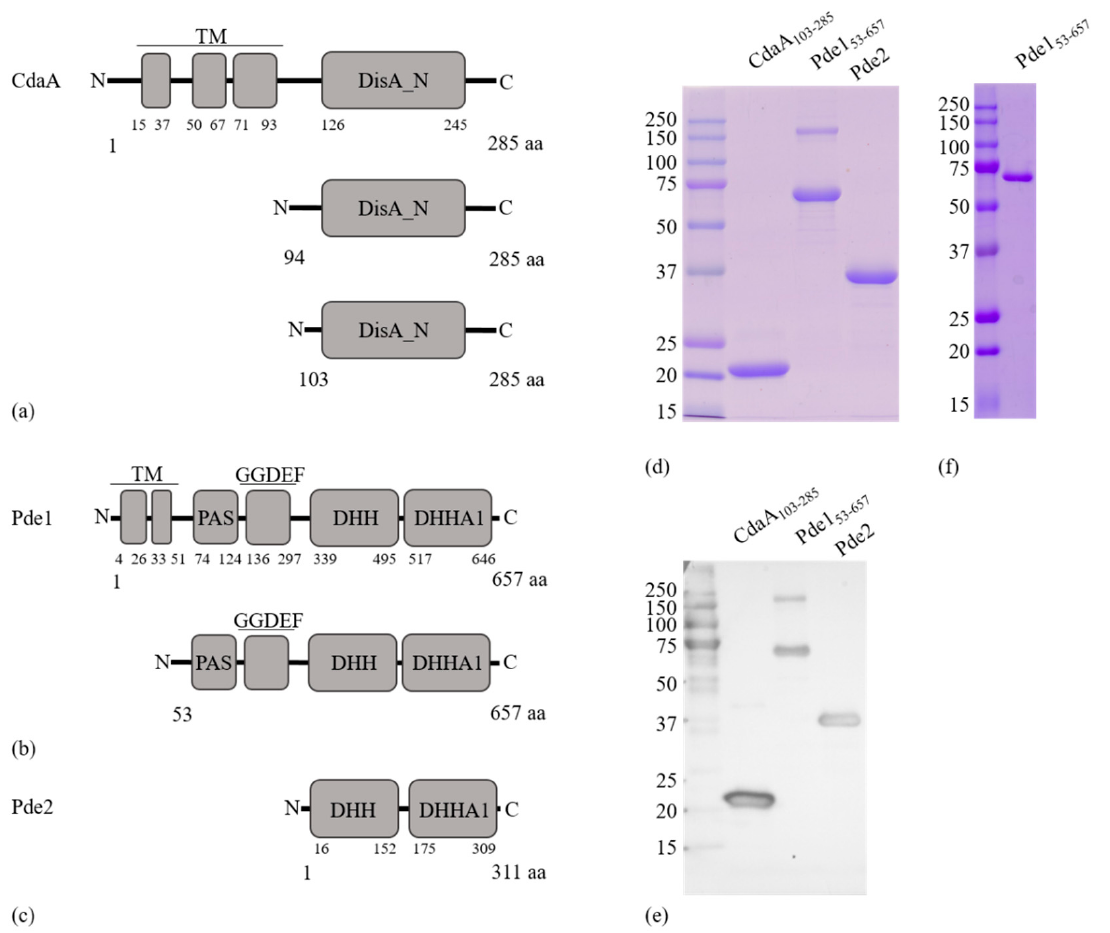
Figure 1. Schematic representation of protein domain organization and construct design. ( a ) Full-length CdaA protein and the expressed truncated recombinant proteins CdaA 94-285 and CdaA 103–285 . ( b ) Full-length Pde1 and the expressed truncated version Pde1 53–657 . ( c ) The expressed full-length Pde2 protein. ( d ) Coomassie stained SDS-PAGE gel showing proteins purified by His-tag a ffi nity followed by Size exclusion chromatography (SEC). ( e ) Western blot of proteins in ( d ) detected by a α His-tag antibody. ( f ) Coomassie stained SDS-PAGE gel showing pure Pde1 53–657 after purification using His-tag a ffi nity. All expressed proteins had an N-terminal 6 x His-Tag included in their sequence which is not indicated in the figures. Legend: N, amino-terminus; C, carboxy-terminus; aa, amino acid; TM, Transmembrane region; DisA_N, Diadenylate cyclase domain; PAS, PAS domain; GGDEF, a degenerate diguanylate cyclase domain where GGDEF motif is changed to GGDQV; DHH, DHH domain; DHHA1, DHHA1